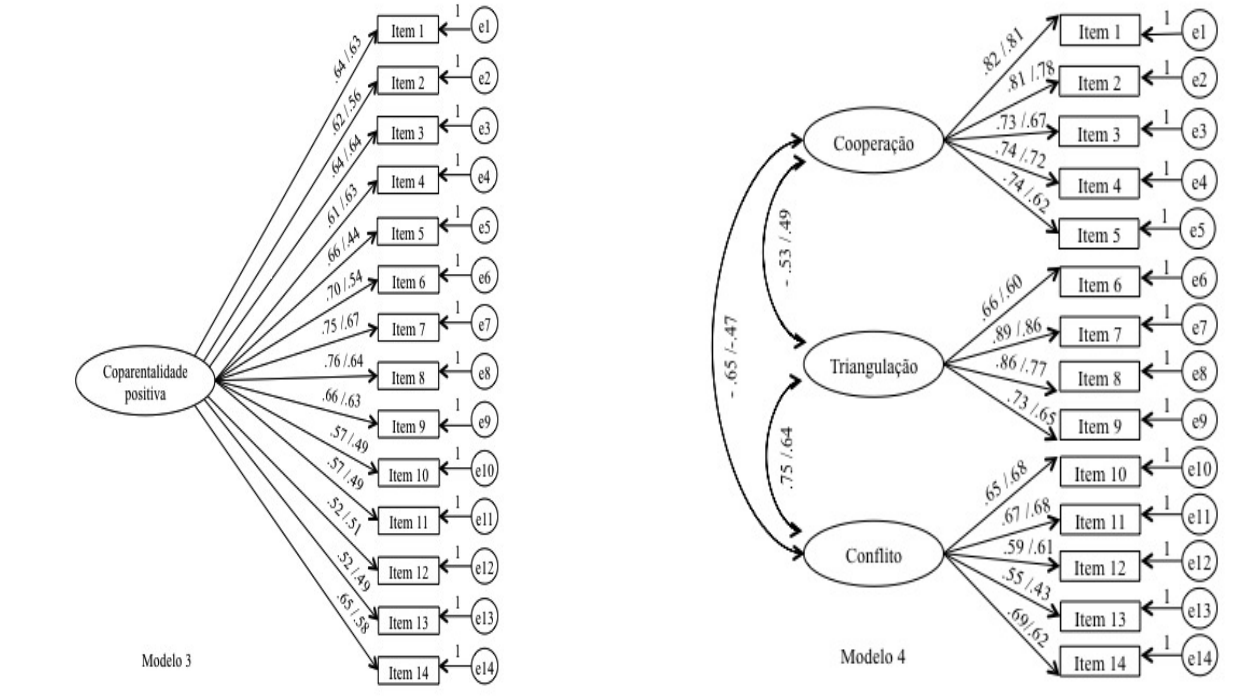
Figura 2 . Modelos alternativos. Modelo 2 – Modelo de três fatores independentes; Modelo 3 – Modelo unifatorial; Modelo 4 – Modelo de três fatores correlacionados. Os primeiros coe fi cientes são referentes às mães e os segundos coe fi cientes são referentes aos